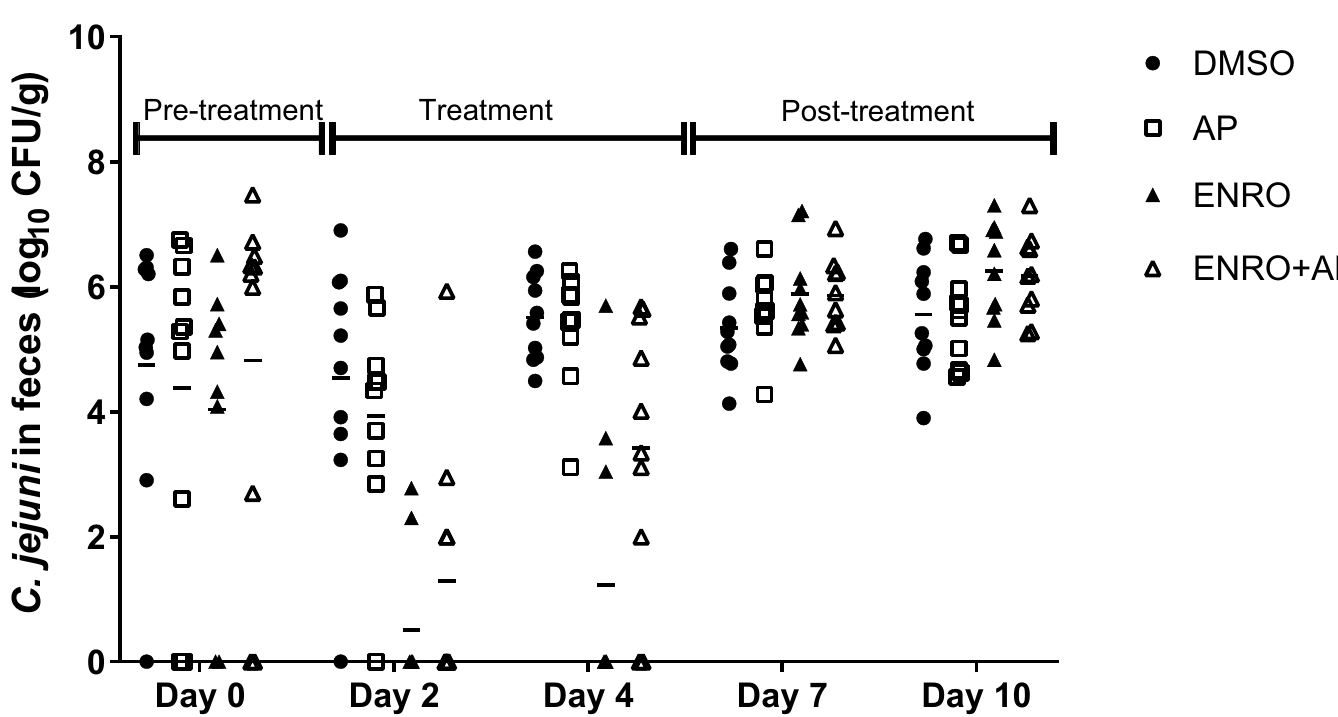
Fig 2. Time-courses of the effects of (-)- α -pinene in the water supply of broiler chickens inoculated with C . jejuni NCTC 11168 3 days before (-)- α -pinene treatment (started day 0). Data are C . jejuni counts (log 10 CFU/g feces) in cloacal swabs from individual broiler chickens in the treatment groups: DMSO, no treatment control; AP, 250 mg/L (-)- α -pinene; ENRO, 50 mg/L enrofloxacin; ENRO+AP, combination of 50 mg/L enrofloxacin and 250 mg/L (-)- α -pinene. The detection limit of the culture method was approximately 2 log 10 CFU/g feces, and the means are indicated by the horizontal